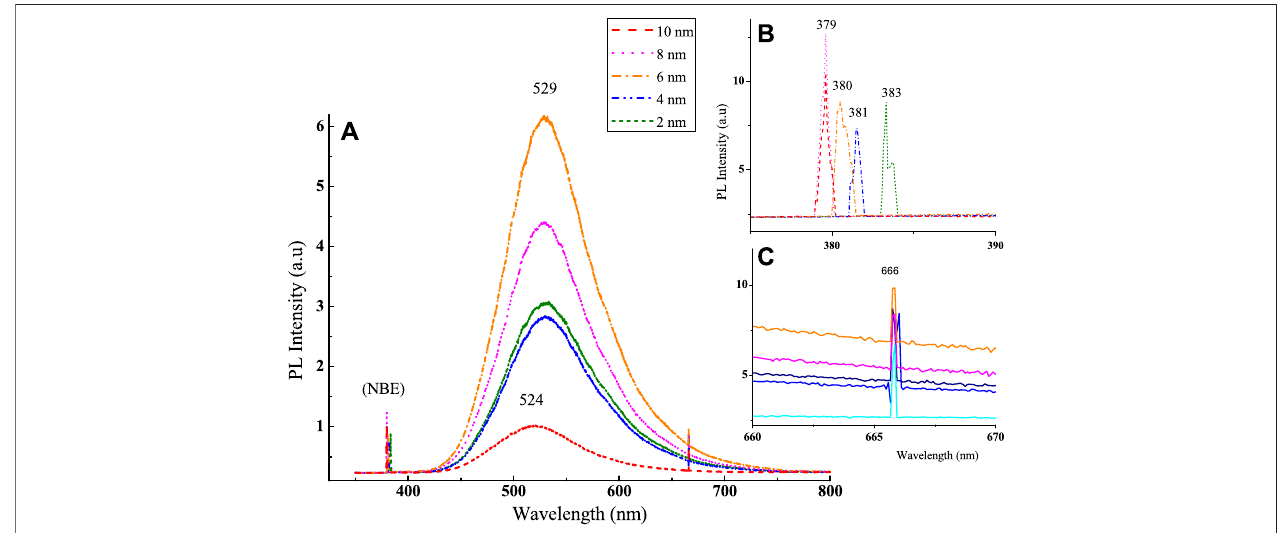
FIGURE 12 | (A) PL spectrum of unannealed Au layer of various thicknesses on Si at room temperature (B) PL spectrum in NBE region and (C) shows Si peaks in the lateral region.